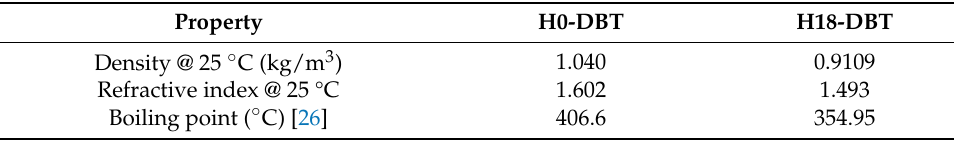
Table 5. Properties of dibenzyltoluene and